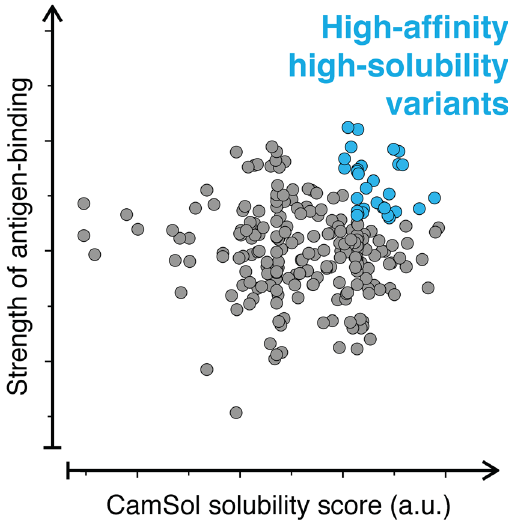
Figure 1. Simultaneous screening of affinity and solubility of antibody libraries. The screening of the antibodies derived from an in vitro discovery experiment (e.g. phage display) can be performed using two parameters: (1) a measured binding strength (e.g. binding affinity or off-rate), and (2) a predicted solubility score (e.g. the CamSol intrinsic solubility; a.u. stands for arbitrary units as the scores are dimensionless). The latter is readily computed from the amino acid sequence, thus enabling the selection from the initial screening of lead antibodies with high affinity and